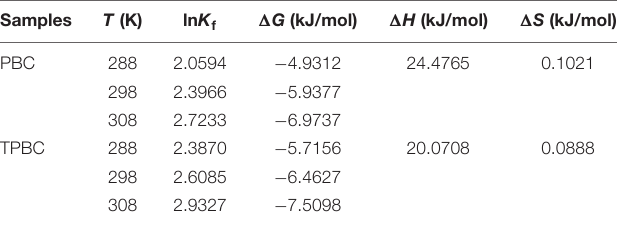
PAS biochar were in better agreement with the pseudo-second- TABLE 5 | Thermodynamic parameters of TC adsorption on